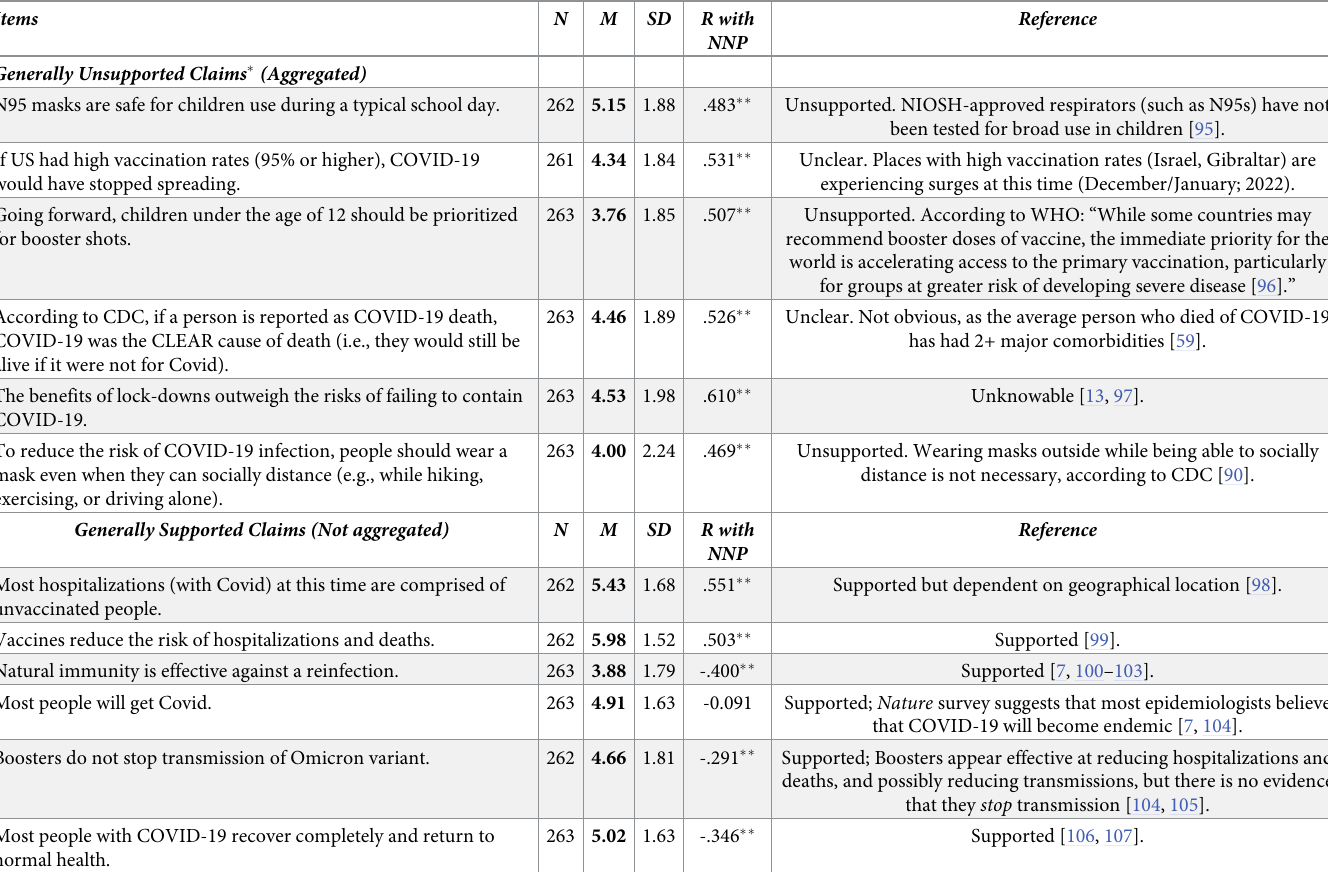
Table 6. Perceived scientific evidence of COVID-19 risks items and correlations with NNP (Sample E; 2022). Items N M SD R with